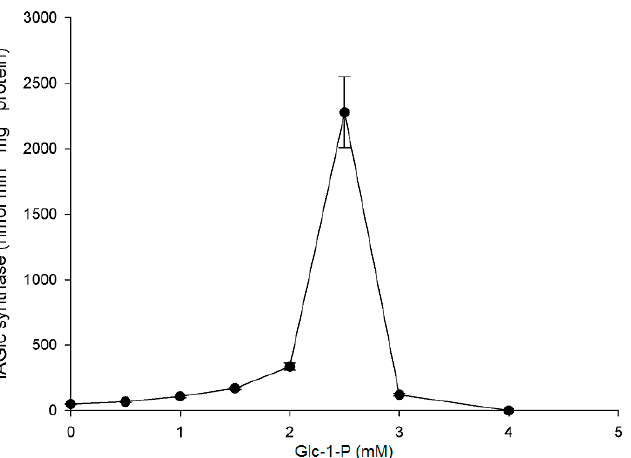
Figure 6. Effect of glucose-1-phosphate (Glc-1-P) on IAGlc synthase. The following concentrations of Glc-1-P were used for this assay: 0; 0.5; 1.0; 1.5; 2.0; 2.5; 3.0 and 4.0 mM. Enzyme activity was determined using [ 14 C]IAA after TLC. Catalytic activity was expressed as the means ± SD for three repetitions.